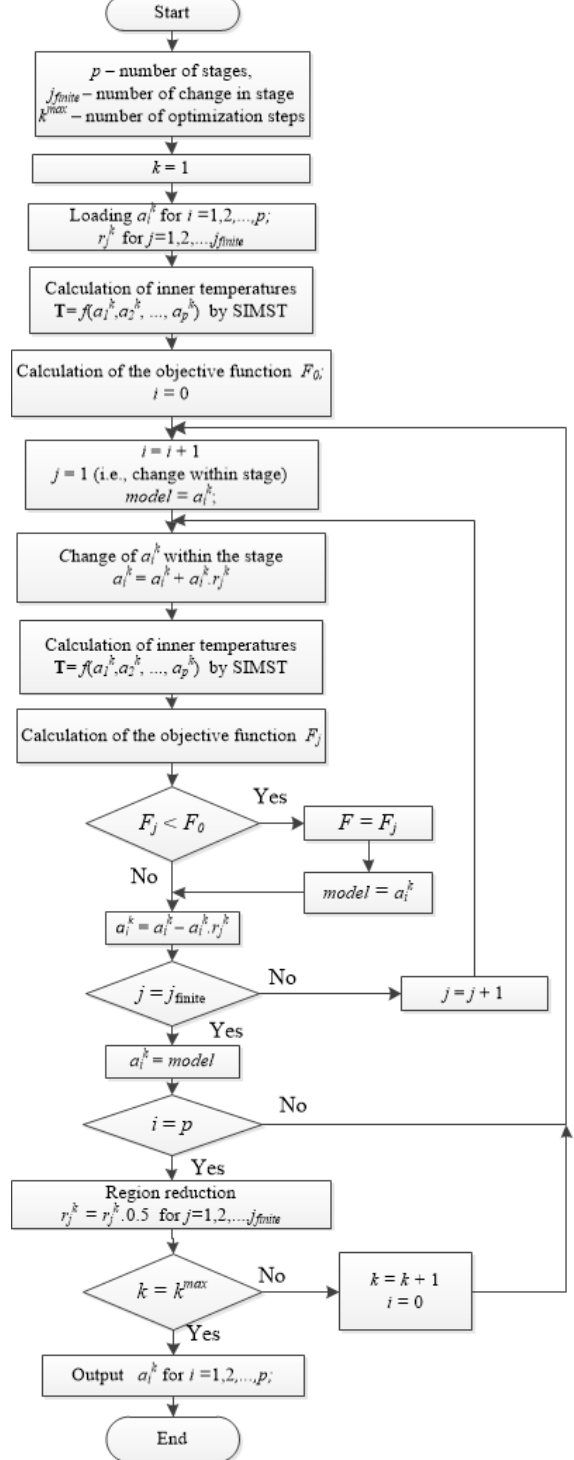
Figure 8. Modified iterative dynamic programming (IDP) algorithm for estimation of thermal